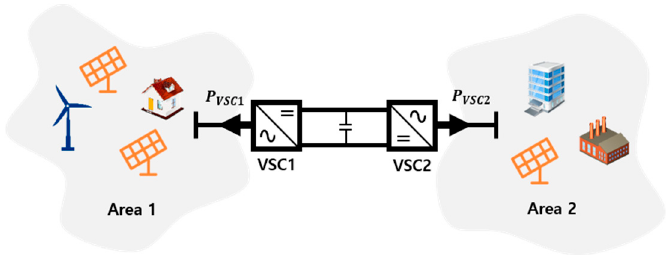
Figure 1. Connection of two networks using medium voltage direct-current (MVDC) link.